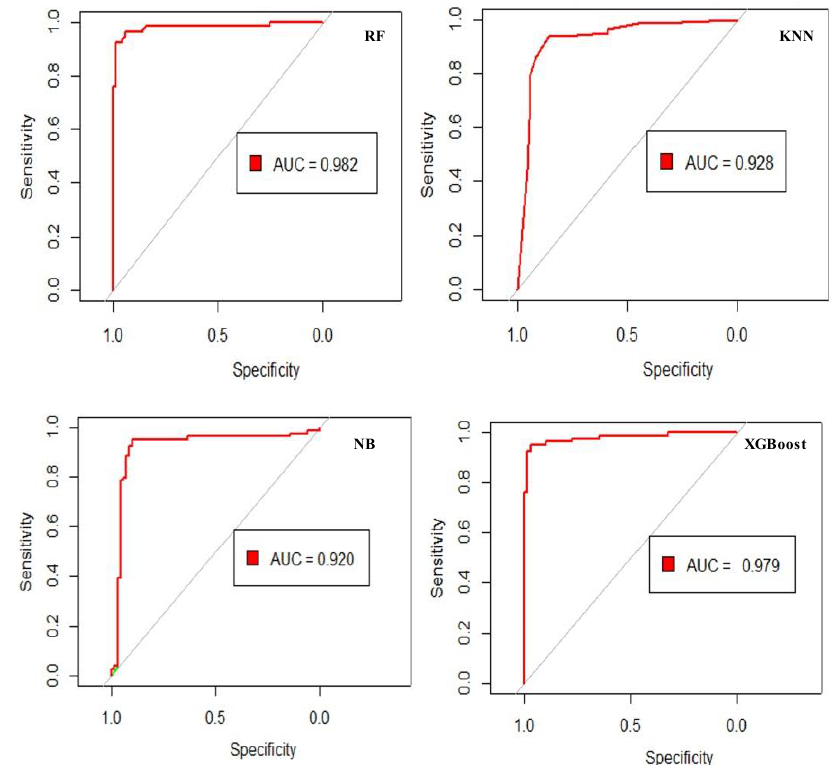
Figure 13. ROC curve of the RF, KNN, NB, and XGBoost models validation.